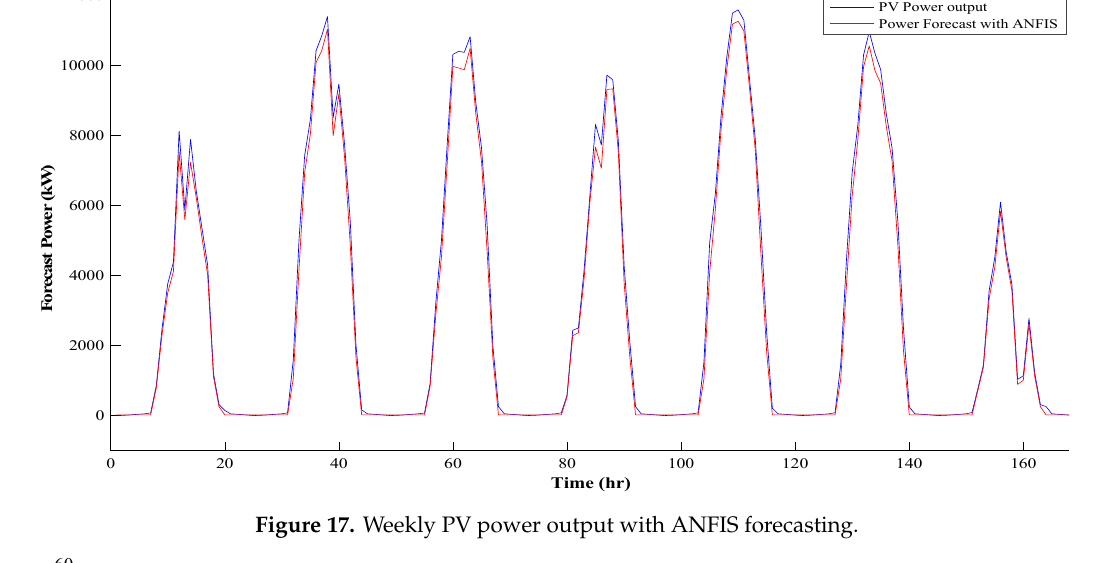
Figure 17. Weekly PV power output with ANFIS forecasting.